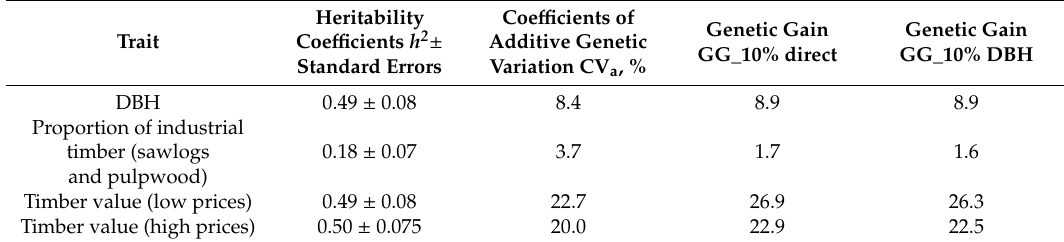
Table 2. Coe ffi cients of heritability ( h 2 ), genetic variation (CV a ) and genetic gain (GG) of progenies of plus-trees of silver birch plantation at the age of 14